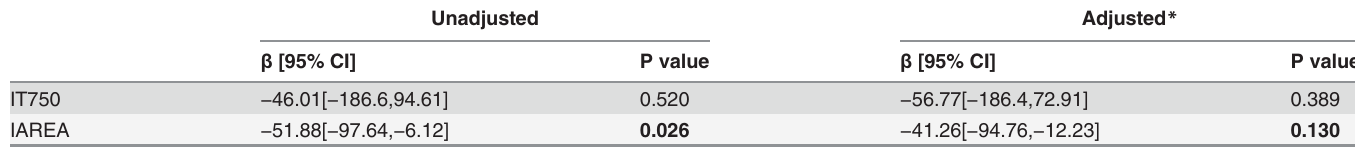
Table 3. Uni- and multivariate linear regression analysis of the association between choroidal thickness and iris parameters.